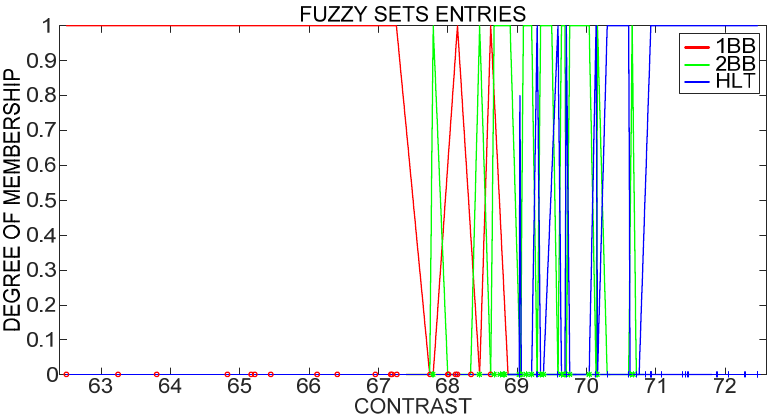
Figure 8. PDFs from contrast values computed through Tamura definition for a healthy motor